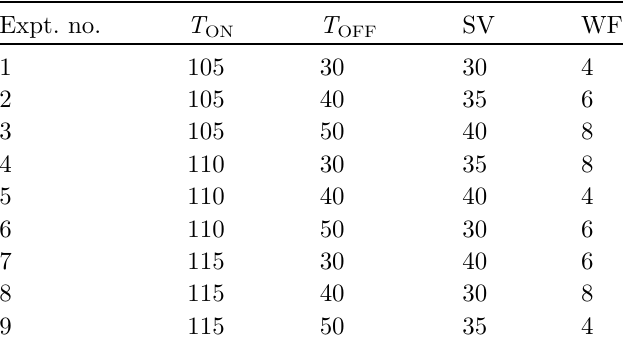
orthogonal array design. 9